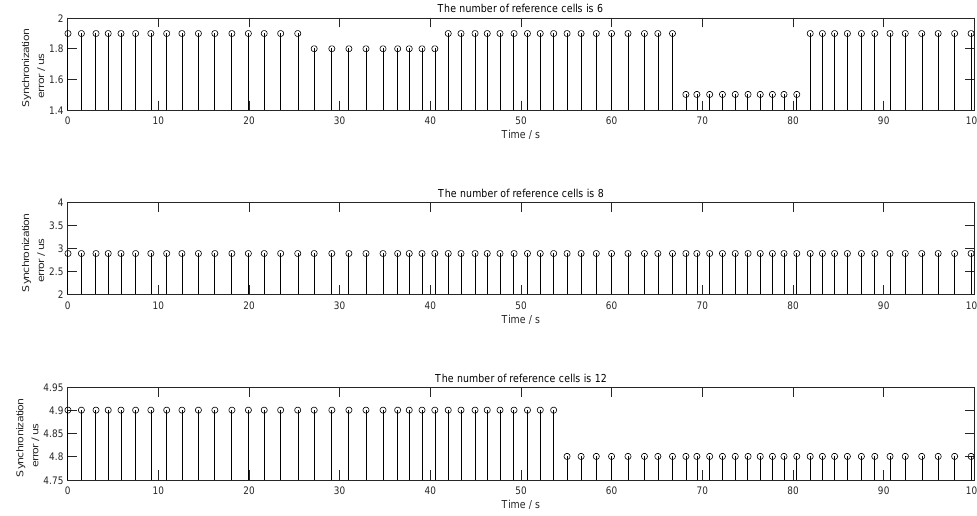
Figure 10. Acceptable synchronization error for different reference cells during tracking